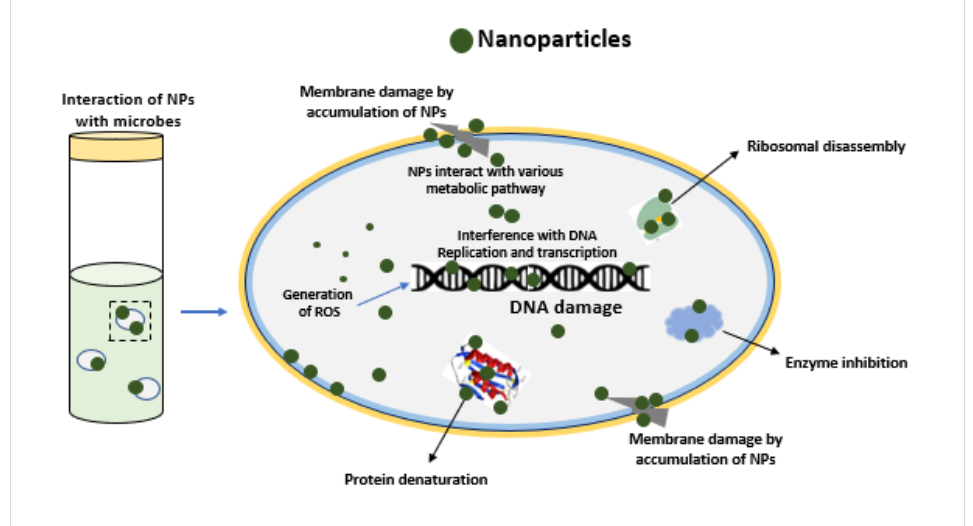
Figure 7. The possible antifungal mechanisms of NPs, including the generation of ROS, rupture of the cell membrane, DNA damage, and enzyme inhibition.